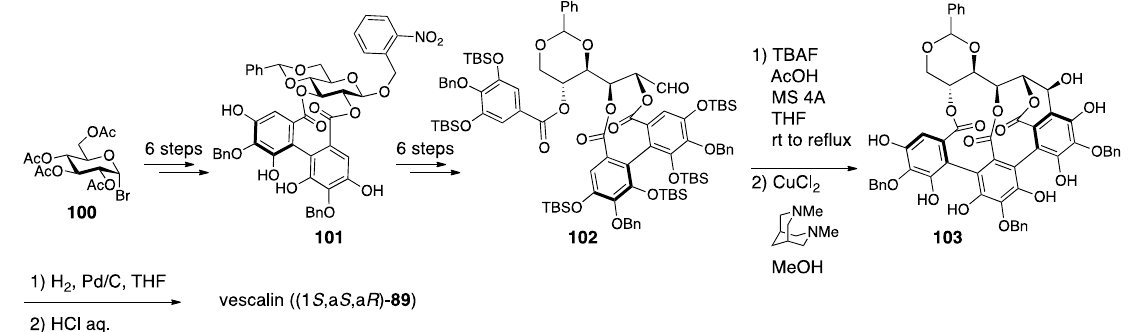
Figure 39. The first total synthesis of vescalin.